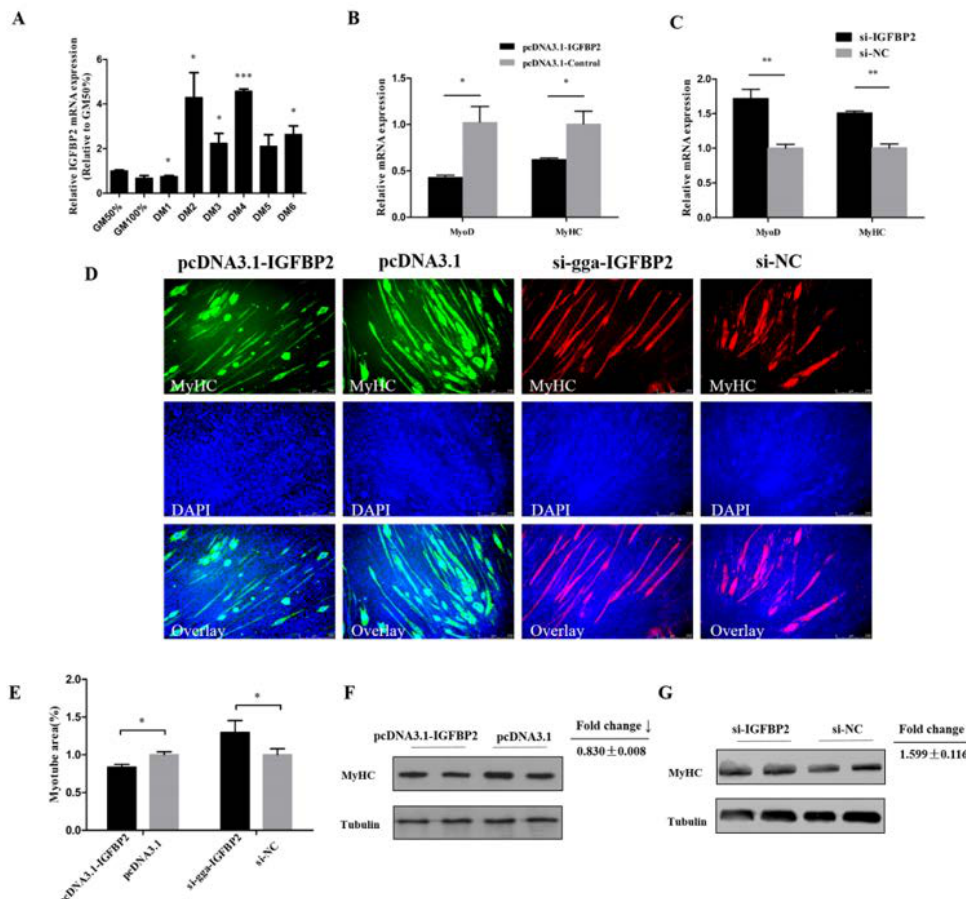
Figure 5. IGFBP2 suppresses myotube formation. ( A ) The relative expression of IGFBP2 during CPM di ff erentiation. ( B , C ) The mRNA level of MyoD and MyHC after overexpression or knockdown of IGFBP2 in CPM cells. ( D , E ) MyHC staining and the myotube area (%) of CPM cells 72 h after overexpression and knockdown of IGFBP2. ( F , G ) The protein level of MyHC after overexpression and inhibition of IGFBP2. Results are shown as mean ± S.E.M. and the data are representative of at least three independent assays. Independent sample t-test was used to analyze the statistical di ff erences between groups. (* P < 0.05; ** P < 0.01, *** P <